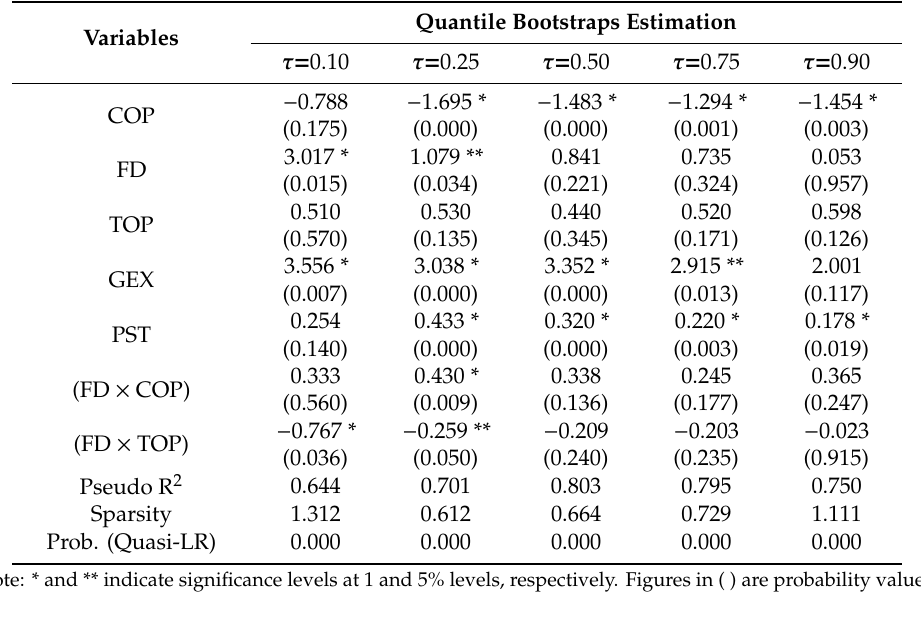
Table 9. The bootstrap quantile regression with iterative e ff ects.